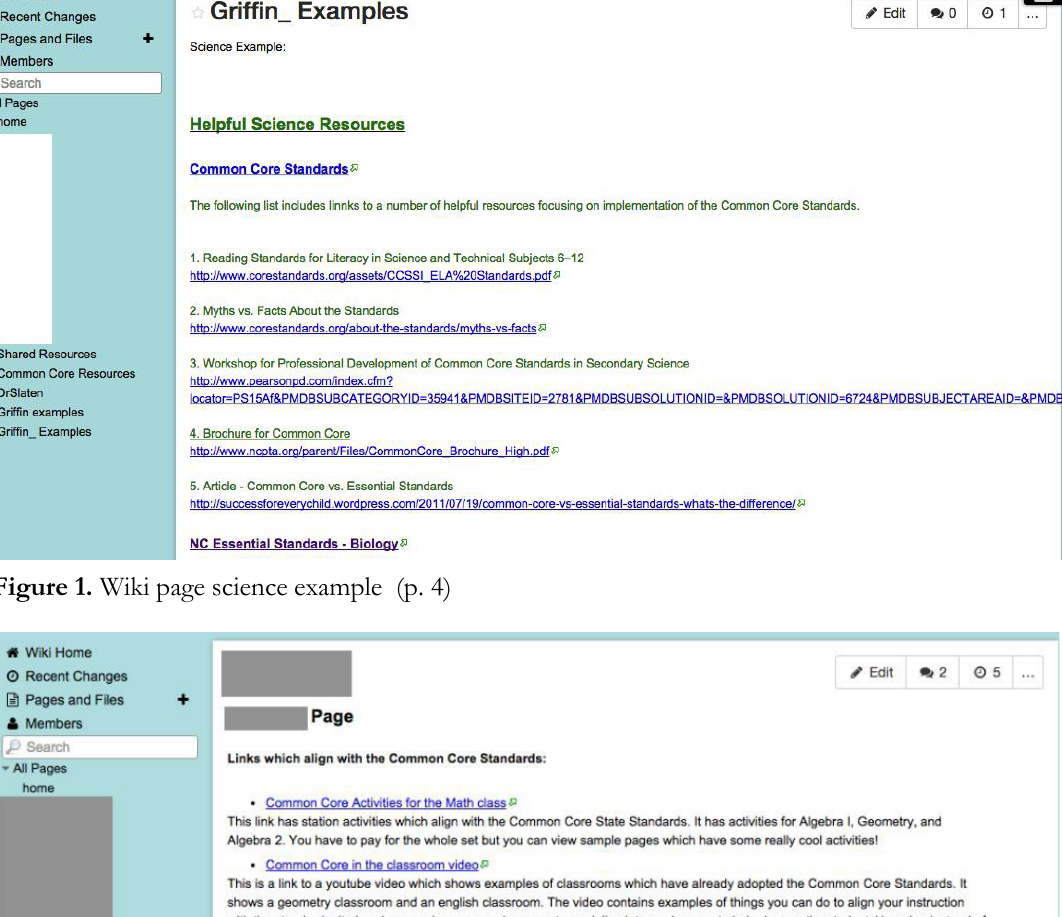
Figure 2. Wiki page mathematics example (p.